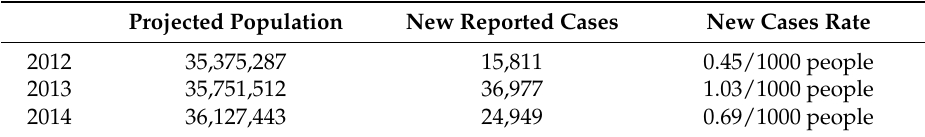
Table 1. Projected population and Dengue Fever Case records.